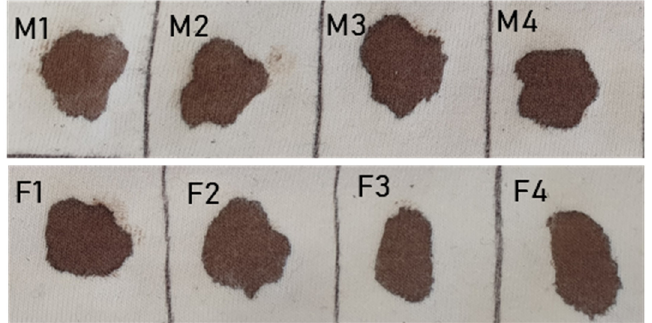
Figure 3. Set of bloodstains of the 8 subjects (males M1–4 and females F1–4) at the sixtieth day of aging.